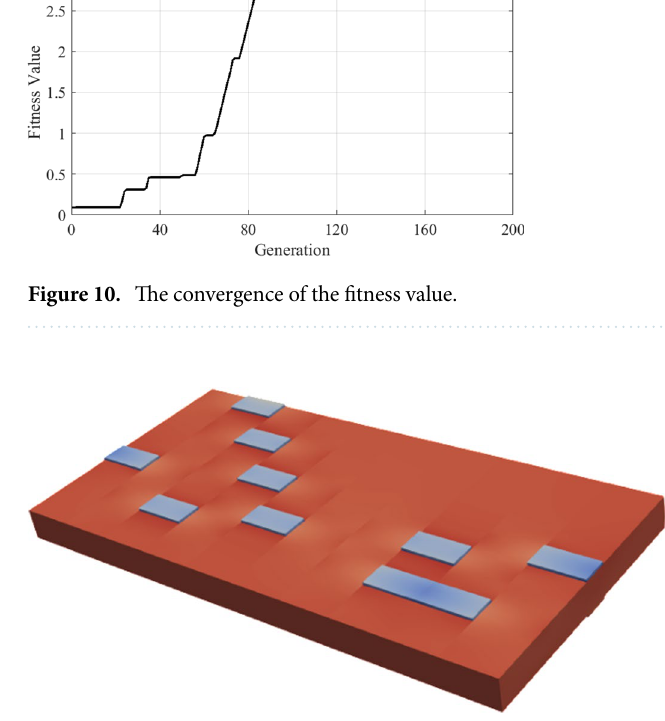
Figure 11. Ten piezoelectric patches on a cantilever thick plate by